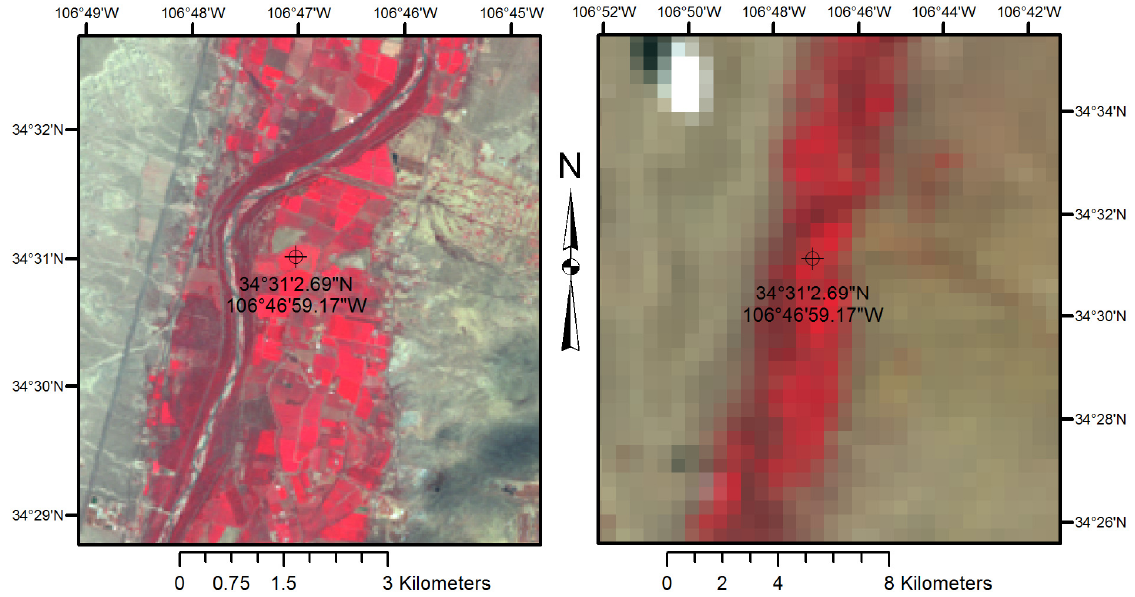
F, obtained from METRIC, from January to September 2007 Figure 10. Variation of ET r (black symbols). High values of ET F following recent precipitation events are shown in r gray color. The solid black line shows the general tendency of the ET